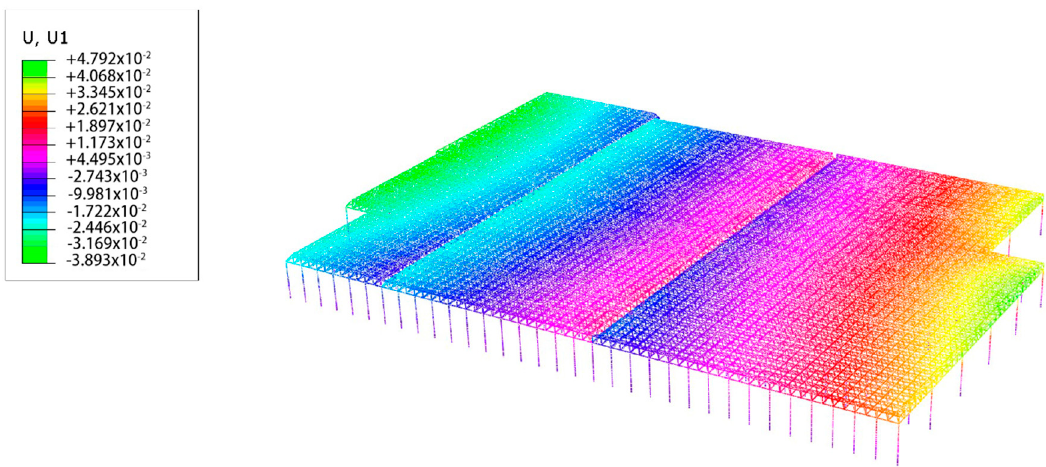
Figure 19. Displacements in the long-edge direction caused by load and thermal effects in the space frame and steel-reinforced concrete column system.